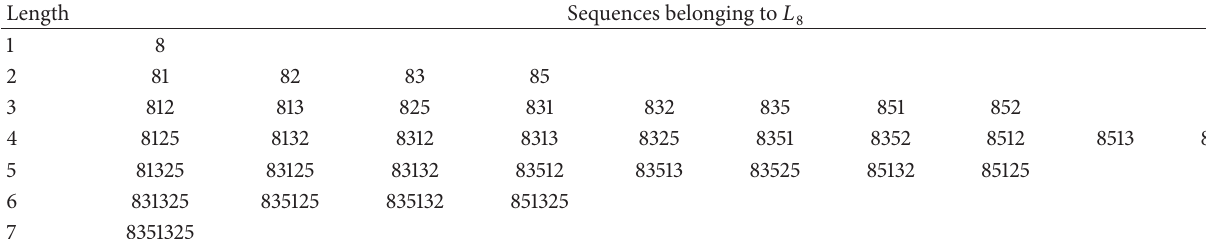
Table 2: Subsequence belonging to 𝐿 8 .